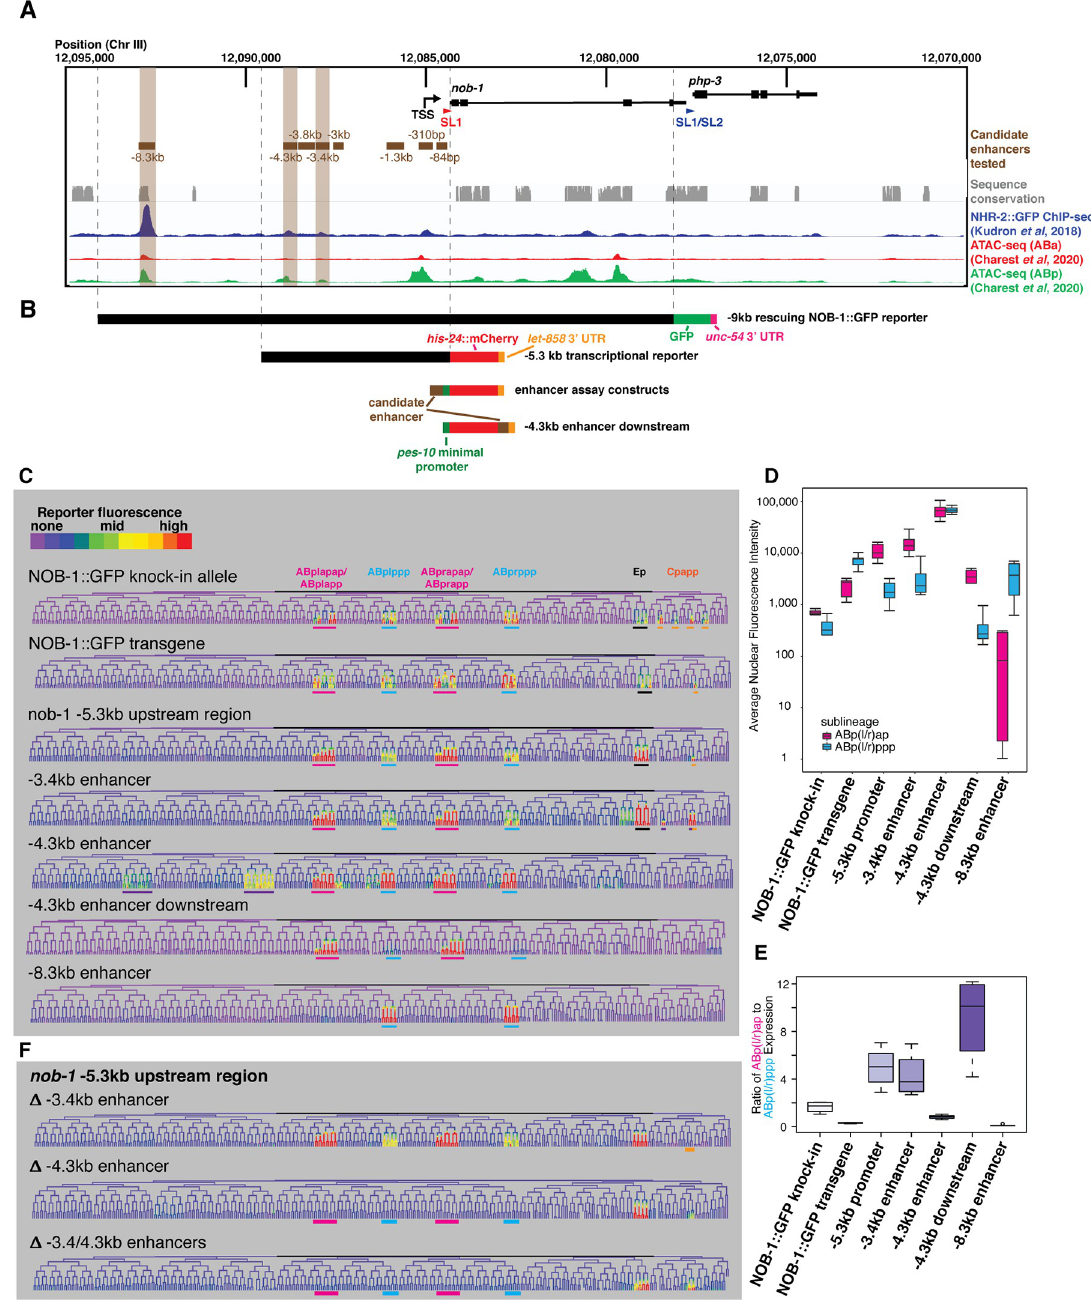
Fig 2. Regions upstream of nob-1/php-3 can recapitulate its expression pattern. A) Genome browser view of the nob-1 / php-3 locus showing the genes (black), candidate enhancers tested (brown), sequence conservation with other nematodes (grey), and NHR-2 ChIP- seq trace (dark blue) from modENCODE [43] and ATAC-seq traces (red:ABa lineage, green: ABp lineage) from Charest et al, 2020 [66]. B) Schematics of the nob-1 reporter constructs examined, shown in alignment with (A). Enhancers were primarily tested in an orientation 5’ to the pes-10 minimal promoter, but a downstream orientation was also used for the -4.3 kb enhancer. C) Lineage trees colored to show expression patterns for the various reporters and tested enhancers with relevant reproducible activity, using a rainbow color scale to increase visible dynamic range. Major expressing lineages are underlined: ABp(l/r)ap: pink, ABp(l/r)ppp: cyan, Ep: black, Cpapp: orange, ectopic: purple. Note the changes in expression driven by the -4.3 kb enhancer depending on its position relative to the pes-10 minimal promoter. D) Average nuclear fluorescence values for cells in the ABp(l/r)ap (pink) and ABp(l/r)ppp (blue) lineages from at least four embryos, shown on a log scale (arbitrary units). E) Ratio of expression in average ABp(l/r)ap cell to the average ABp(l/r)ppp cell at the 350 cell stage for at least 4 embryos (n = 4–7). F) Lineage trees showing expression driven by the nob-1–5.3 kb upstream region reporter with the -3.4 kb and/or -4.3 kb enhancers are deleted. Lineages where expression is lost are underlined with colors as in